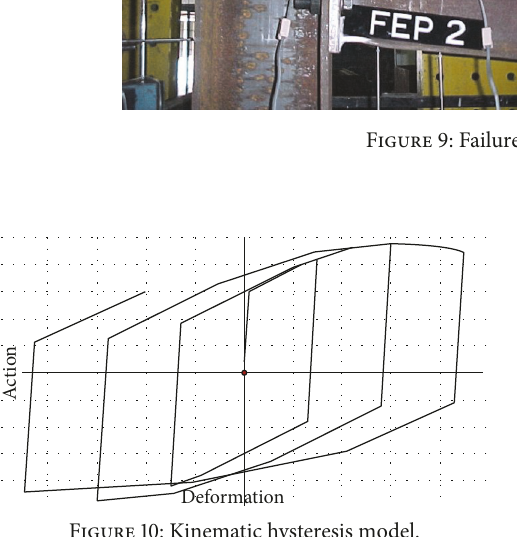
Figure 10: Kinematic hysteresis